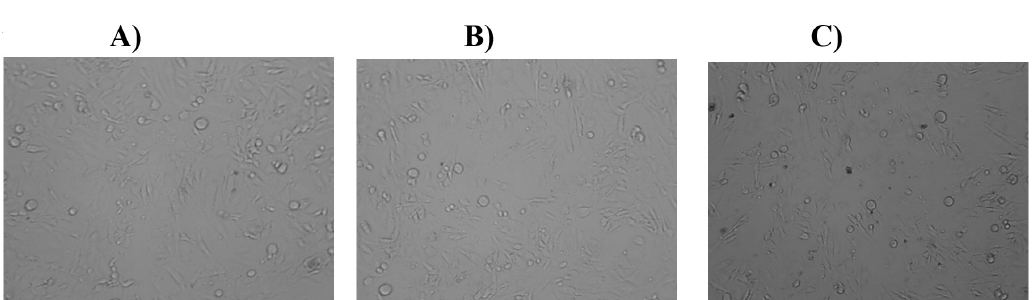
Fig. 5. Inverted light microscopy images of 3T3 L1 cell line after exposure to A. suaveolens , and Metformin. From ‘A’ to ‘C’ where A) control B) Standard Metformin drug and C) 400µg concentration of A. suaveolens